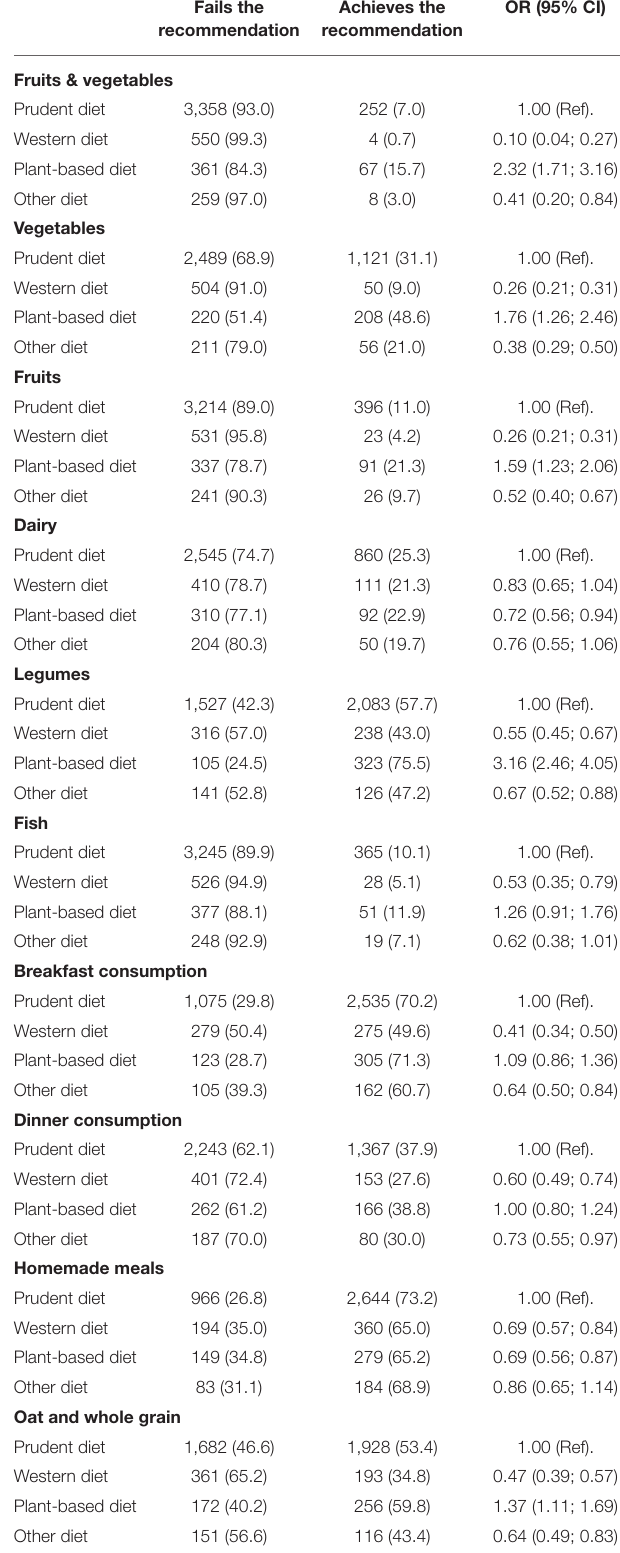
TABLE 2 | Association between following a prudent diet and socio-demographic characteristics. Characteristic OR (95% IC)